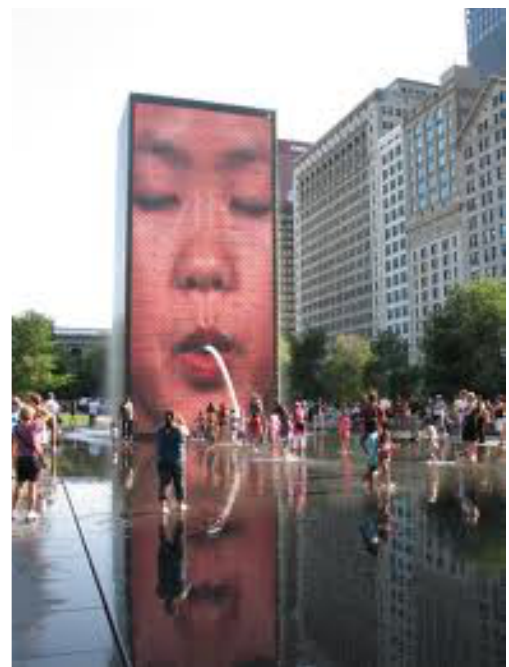
Figure 2. The Crown Fountain by Catalan artist Jaume Plensa.